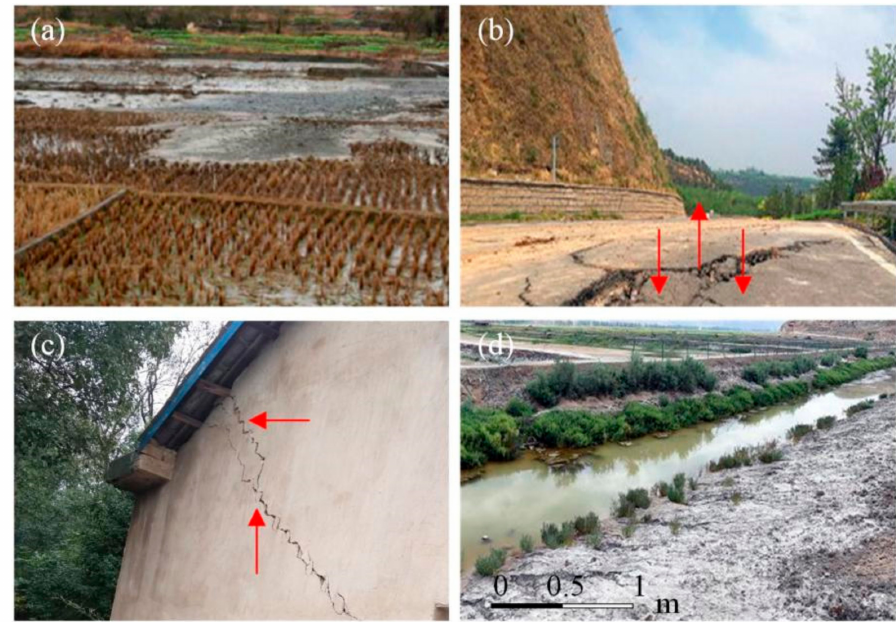
Figure 8. Field pictures of the residential area near the study area: ( a ) area with land saliniza- tion; ( b ) uneven displacement on the road; ( c ) cracks on the wall of a house; ( d ) a water pit in the salinized area.